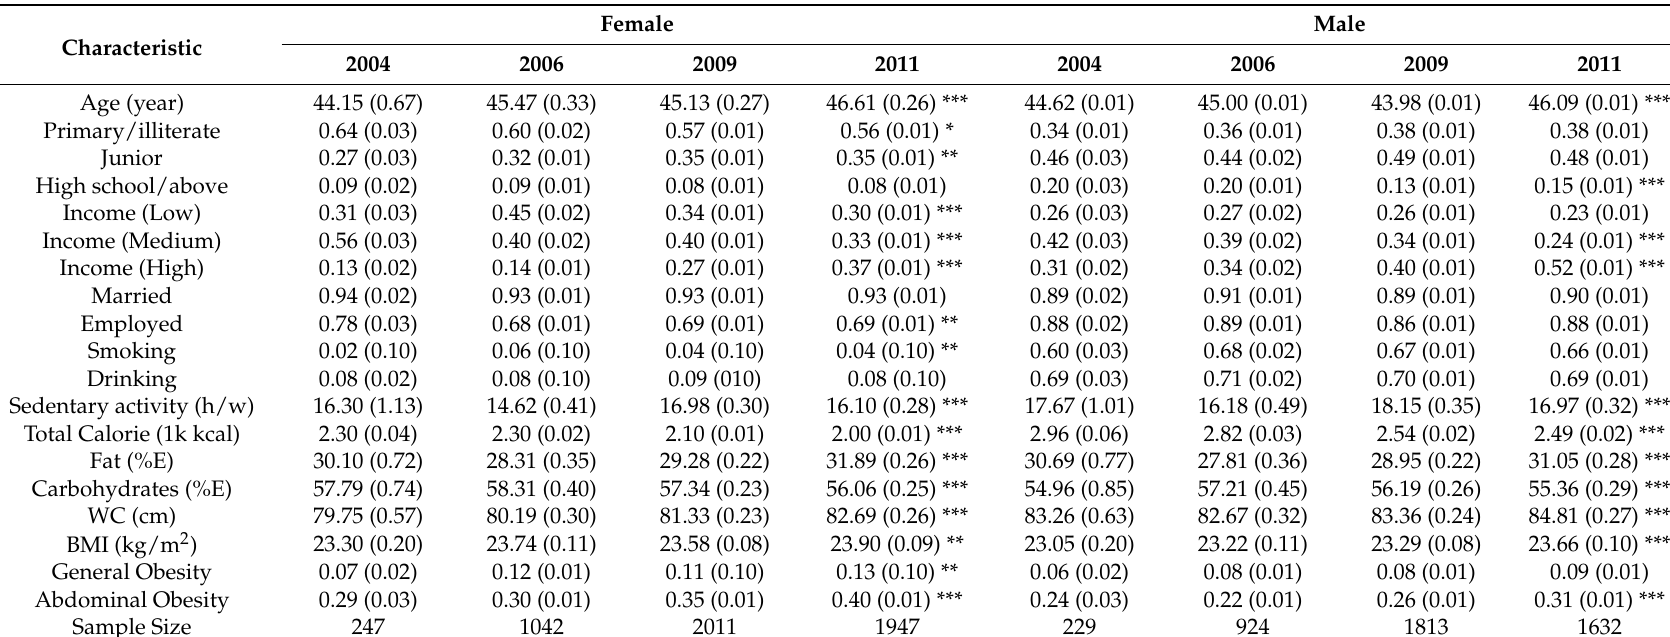
Table 2. Basic characteristics of trends of NRCMS participation in different gender groups from 2004 to